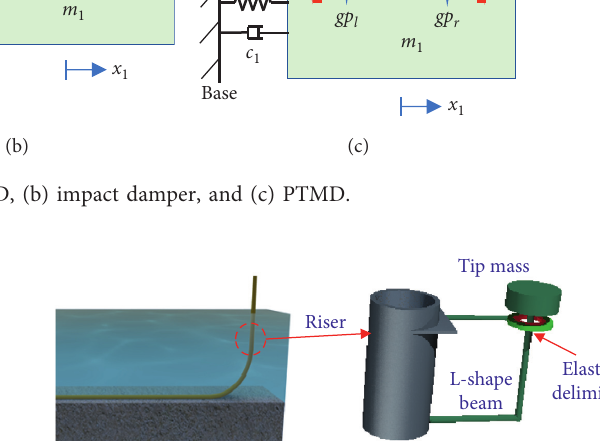
Figure 4: : The PTMD designed for an